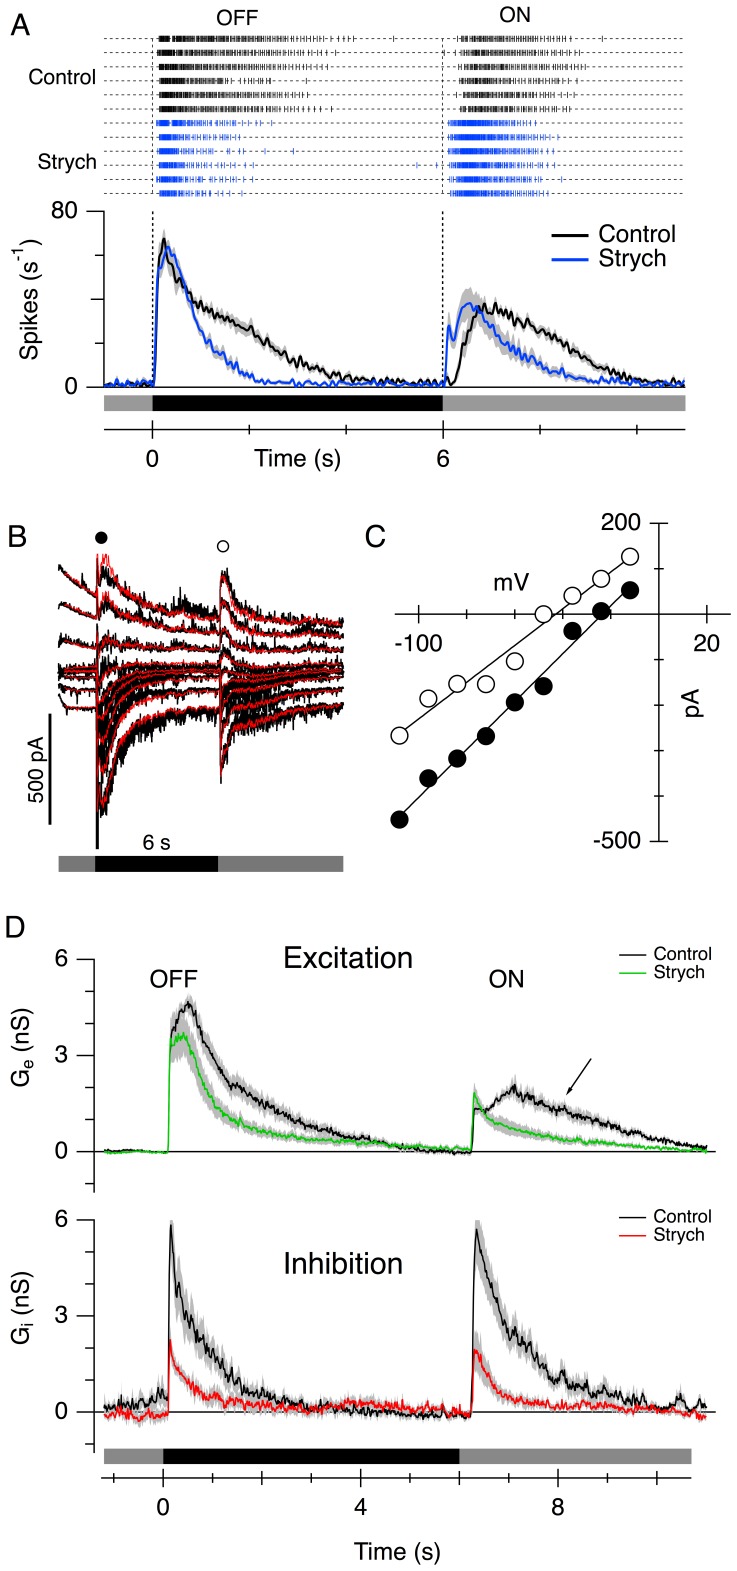
Effects of strychnine on the centre responses of LEDs.(A) The upper panel shows representative spike-raster plots of spike times for 6 consecutive responses to a small dark spot (100 µm diameter) flashed in the centre of the LED’s receptive field for 6 s, in control (black) and with 0.5 µM strychnine (blue); the lower panel shows the spike-time histograms averaged from 8 cells in control (black line) and during application of strychnine (blue line). The stimulus timing is shown by the shaded bars below the traces. The shading shows the standard error of the mean (SEM). (B) Example light-evoked membrane current recorded during stimulation of an LED at holding potentials from –110 to +25 mV in 15 mV steps; each trace shows the response to a single stimulus. The membrane potential was stepped to a new holding potential 2 s before the light stimulus. The stimulus timing is shown by the bars below the traces. The red traces show the current traces calculated from a linear combination of excitatory and inhibitory conductance components. The average of these components for 8 cells is shown in D. (C) Example current-voltage relations of the net light-evoked synaptic currents sampled at two time-points indicated by the filled (OFF) and open (ON) circles in B. The data points were sampled at equally spaced intervals between −108 and −12 mV from interpolations of series-resistance corrected I-V relations. The lines illustrate the linear regressions used to obtain the total synaptic conductance, GT, and synaptic reversal potential, Vr at each time-point. The magnitude of the excitatory and inhibitory conductances at each time-point were calculated from these values (see Methods). The calculated conductances accurately reproduced the recorded currents, as shown by the red traces in B. (D) Light-evoked synaptic conductance calculated from voltage-clamp experiments during a dark-spot stimulus as for A. The upper panel shows the excitatory conductance (Ge) averaged from 8 cells in control (black trace) and during application of 0.5 µM strychnine (green trace). The lower panel shows the average inhibitory conductance Gi in the same 8 cells in control (black trace) and in the presence of 0.5 µM strychnine (red trace). Strychnine suppressed the peak amplitude of the OFF inhibition by 62±10% (P = 0.0020), and the ON inhibition by 65±6% (P<0.001). The shading shows the SEM.